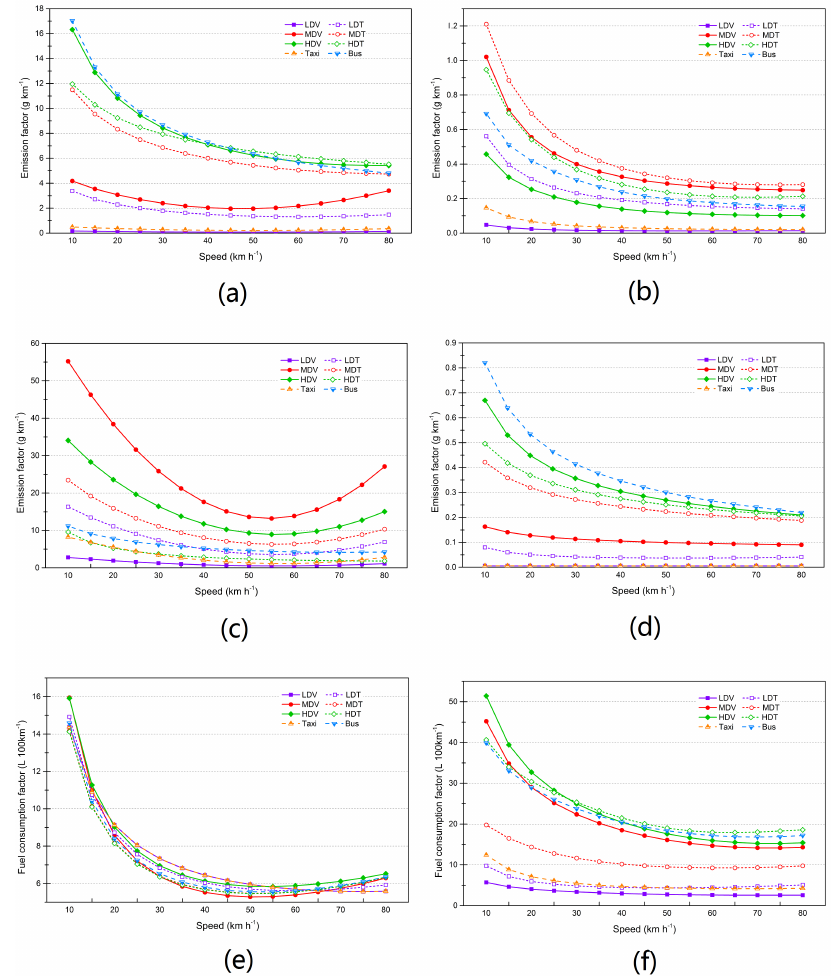
Figure 1. Emission factors of NO x , HC, CO, PM and fuel consumption factors of gasoline and diesel (Huo et al., 2009; Hu et al., 2012; Wu et al., 2012; Wang et al., 2013): (a) emission factors of NO x , (b) emission factors of HC, (c) emission factors of CO, (d) emission factors of PM, (e) fuel consumption of gasoline and (f) fuel consumption factors of diesel.